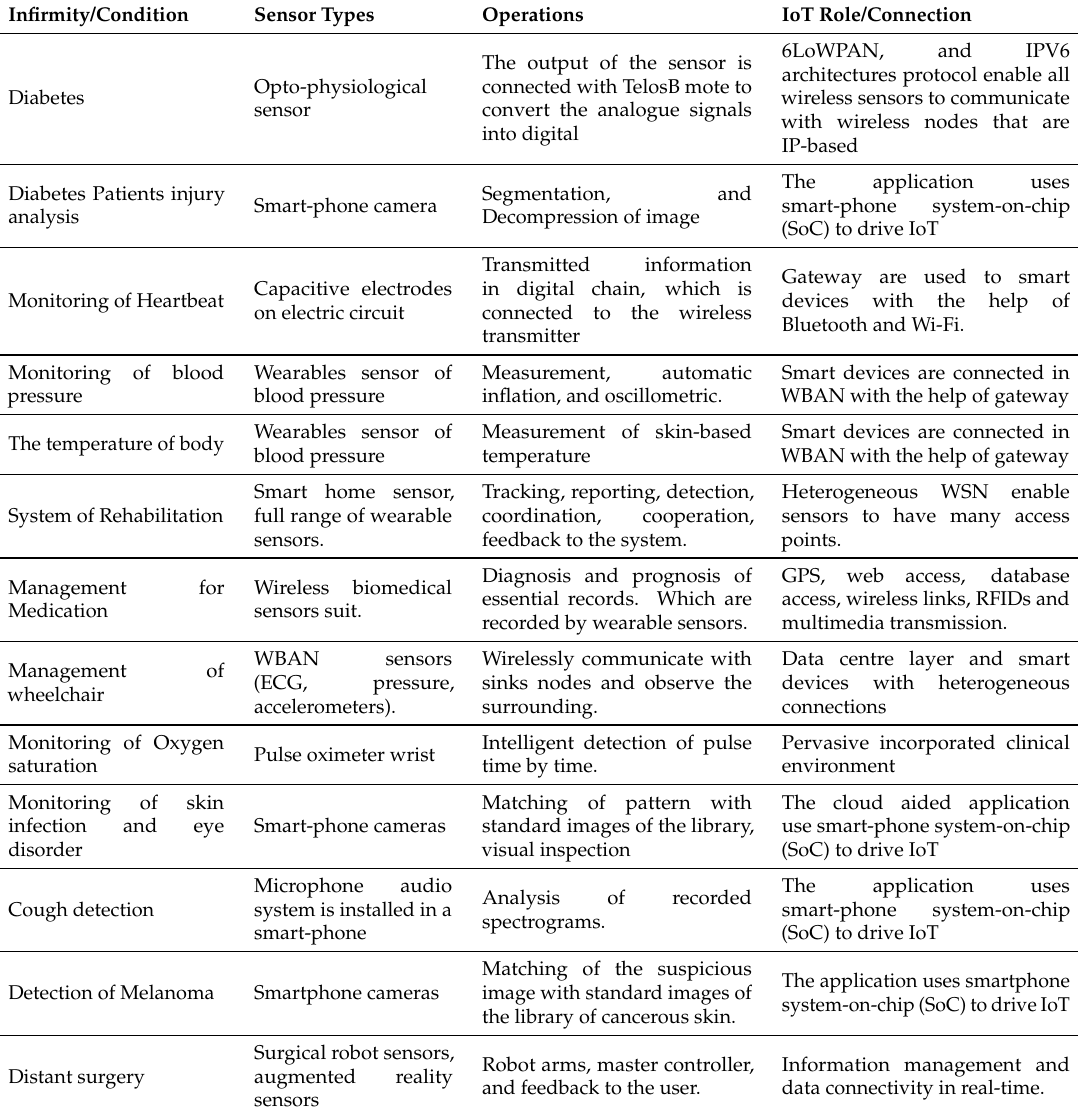
Table 3. Internet of Things (IoT) health-care